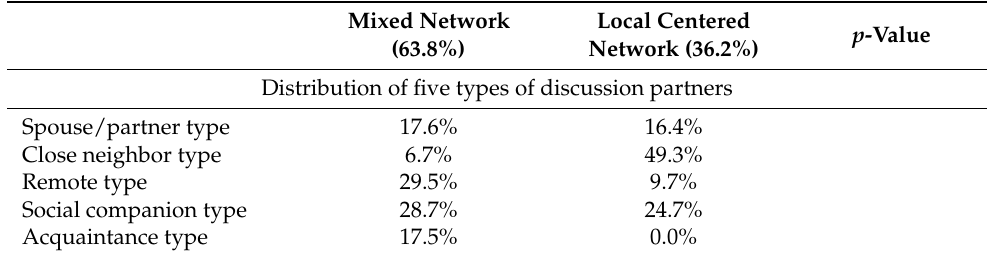
Table A3. Distribution of five types of discussion